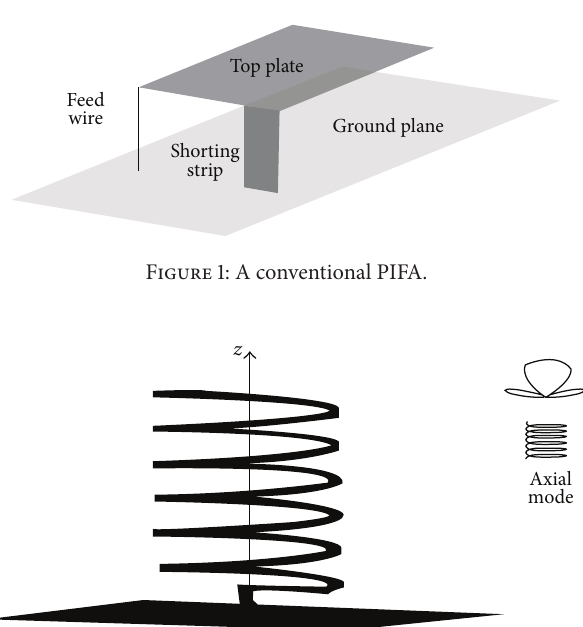
Figure 2: A helical antenna above ground plane operating on axial